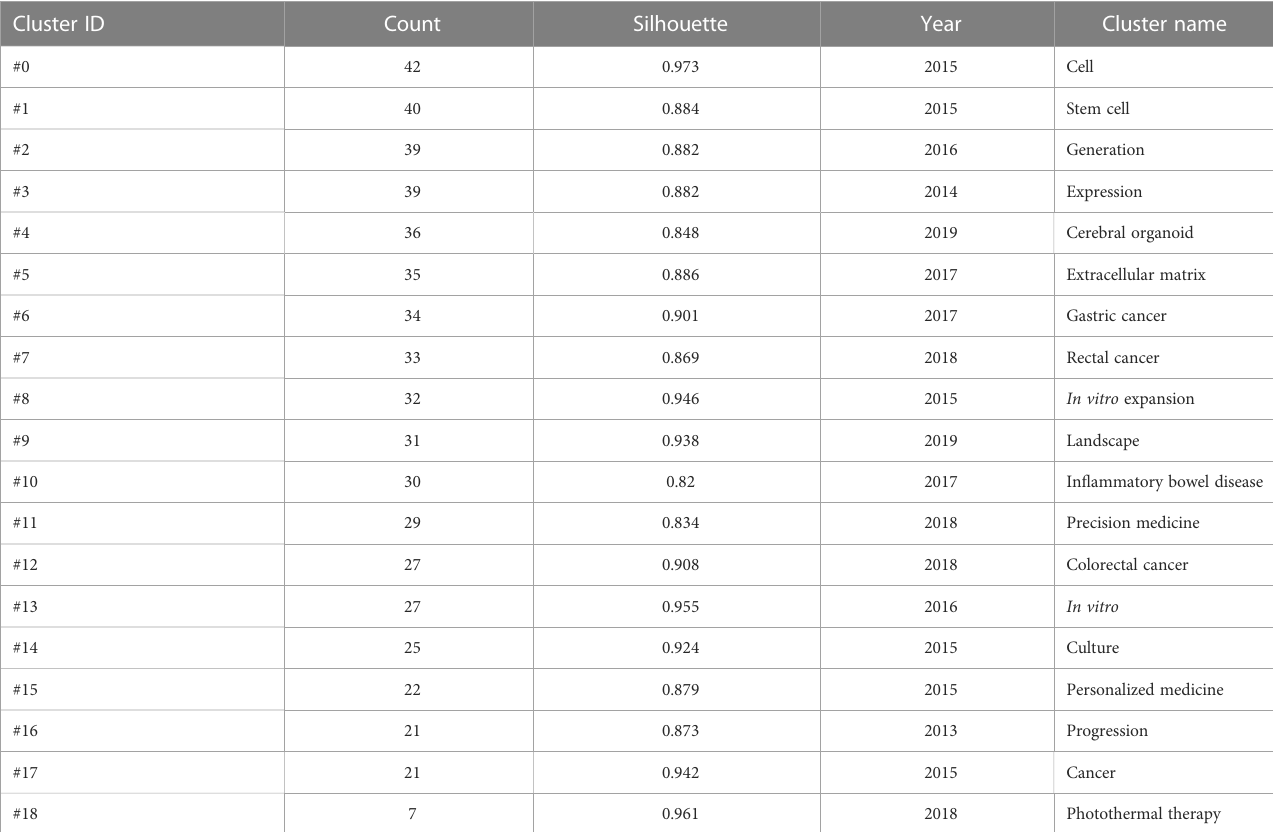
TABLE 8 Keyword clusters from the analysis of tumor organoids. Cluster ID